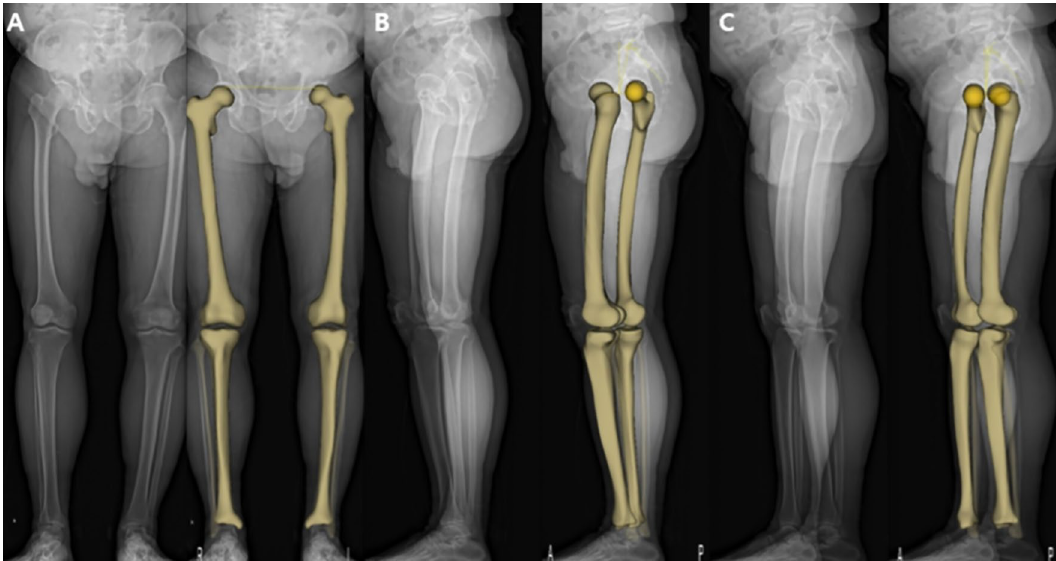
Figure 2. Three-dimensional (3D) model based on the EOS imaging system. Anteroposterior ( A ) and lateral radiographs ( B and C ) are acquired for 3D modeling. The 3D model is adapted to the osseous contours on